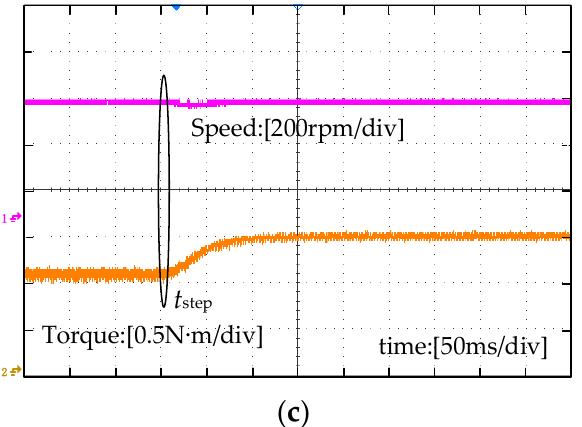
Figure 10. Dynamic experimental waveforms of ECL motor driver under the proposed control